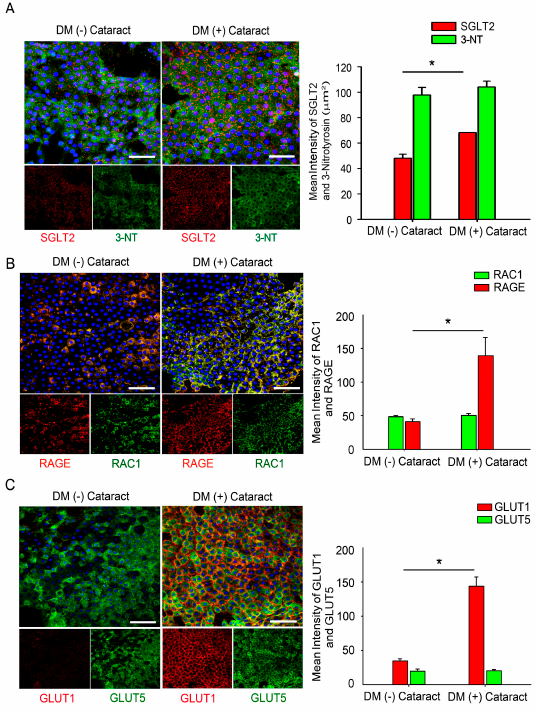
Figure 1. Glucose transporters (GLUTs) may act through the receptor for advanced glycation end products (RAGE) and induce Ras-related C3 botulinum toxin substrate 1 (RAC1) expression and superoxide generation in the lens tissue of cataract patients with diabetes mellitus (DM). ( A ) Representative fluorescence images of sodium/glucose cotransporter 2 (SGLT2)- and 3-NT-positive cells (green) and SGLT2-positive cells (red) in lens epithelial tissue from cataract patients with and without DM. Cell nuclei are counterstained with 4 ′ ,6-diamidino-2-phenylindole (DAPI) (blue). ( B – C ) Representative fluorescence images of RAGE- and GLUT1-positive cells (green) and RAC1- and GLUT5-positive cells (red) in lens epithelial tissue from cataract patients with and without DM. Cell nuclei are counterstained with DAPI (blue). Scale bar: 20 µ m. Quantified values (right) are the means ± SEMs ( n = 10 per group, separate experimental groups in each figure). * p <